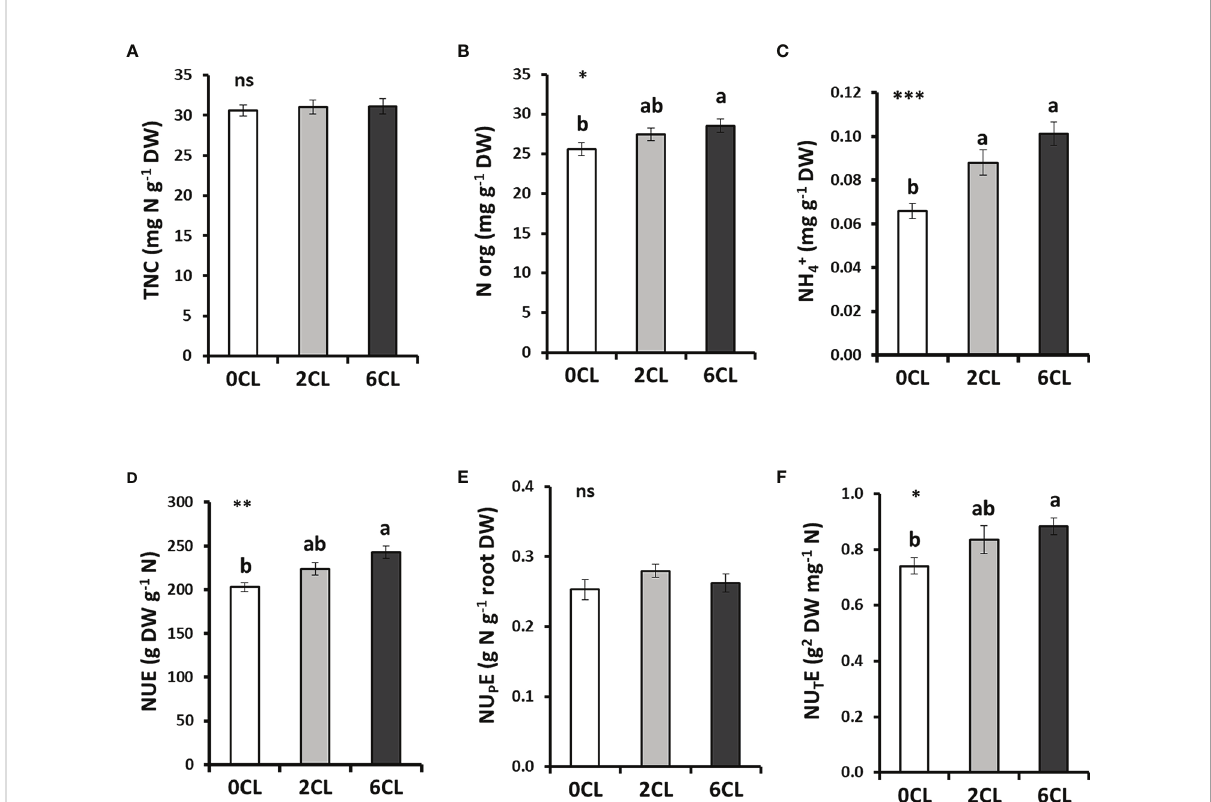
FIGURE 3 Effect of Cl − nutrition on the content of nitrogen (N) forms and N use ef fi ciency parameters. Tobacco plants were treated with 0, 2 and 6 mM of Cl − salts (CL), and supplemented with a mix of sulphate+phosphate salts to maintain a similar cationic balance. The contents of total N (TNC) (A) , organic N (N org) (B) , and ammonium ( NH + 4 ) (C) are shown. Nitrogen use ef fi ciency (NUE) (D) , N- NO − 3 uptake ef fi ciency (NU P E) (E) , and N- NO − 3 utilization ef fi ciency (NU T E) (F) . Mean values ± SE, n =12. Statistics was calculated through ANOVA, where mean values with different letters are signi fi cantly different according to Tukey ’ s test at P ≤ 0.05. Levels of signi fi cance: * P ≤ 0.05; ** P ≤ 0.01; *** P ≤ 0.001; and ‘ ns ’ P > 0.05. DW, dry